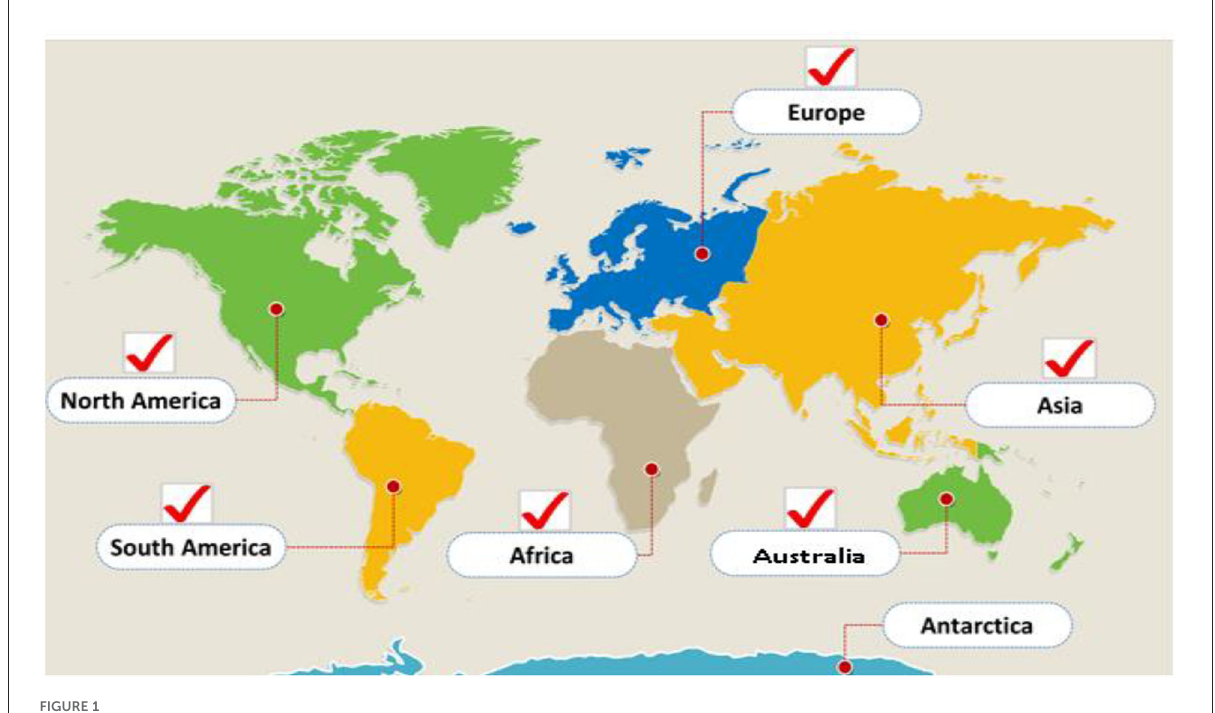
FIGURE1 Geographical distribution of